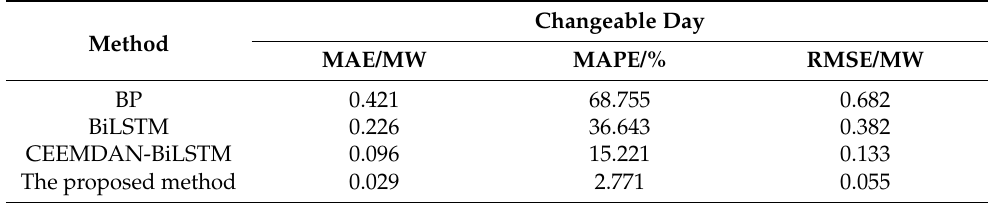
Table 1. Comparison of the PV power forecasting errors of different methods.